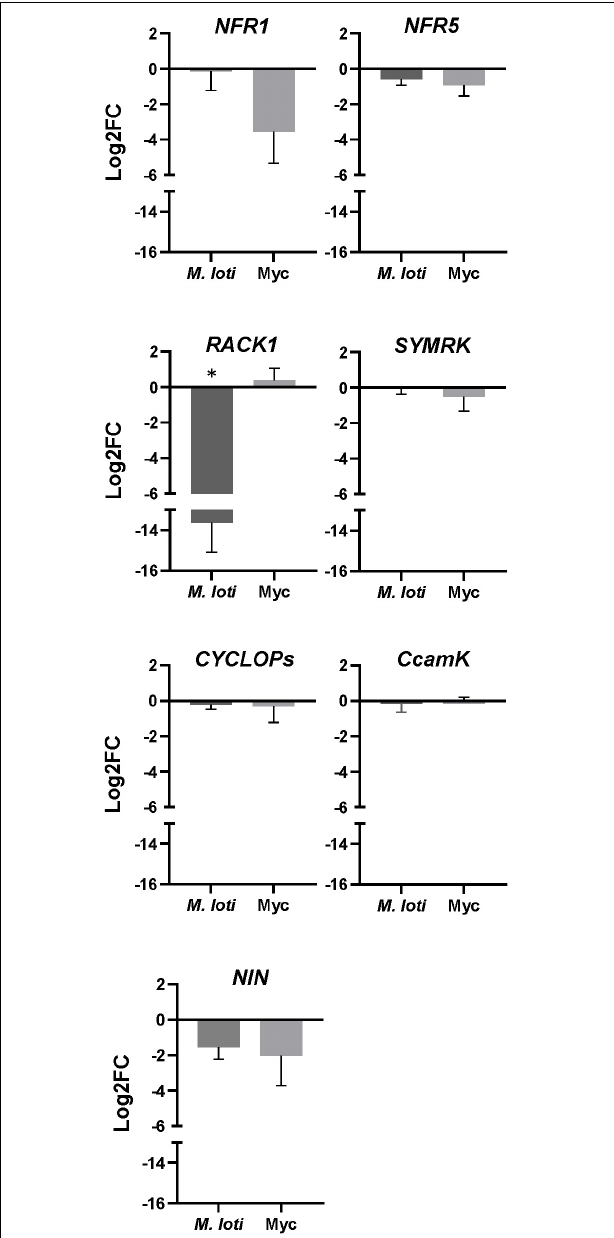
FIGURE 6 | RSP but not CSSP gene expression is altered in the rop3 mutant. Expression analysis of indicated symbiotic genes was performed by qRT-PCR for Gifu wild-type and rop3 mutant plants inoculated either with M. loti (at 7 DPI) or with R. irregularis (at 2 MPI). Data show the ratio of Log2FC values obtained from rop3 vs. Gifu wild type plants. Three independent experiments each with 3 biological replicates were performed. The asterisk indicates statistical significance between rop3 and Gifu wild-type according to one way ANOVA and a post hoc analysis ( p <